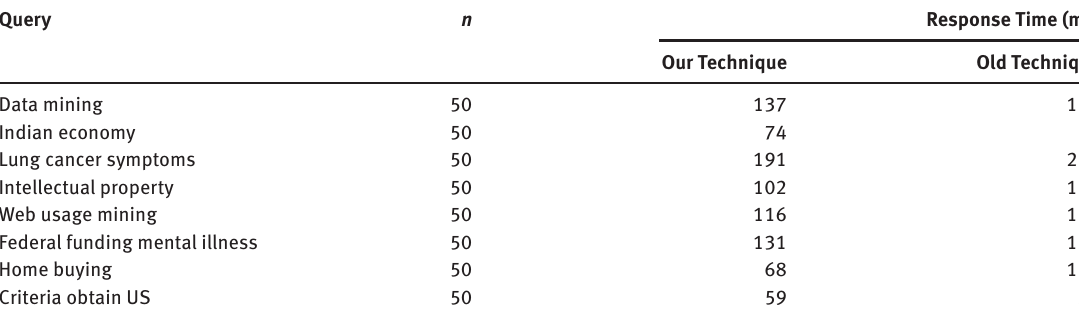
Table 3: Response Time Comparison in Terms of Top 50 Links. Query